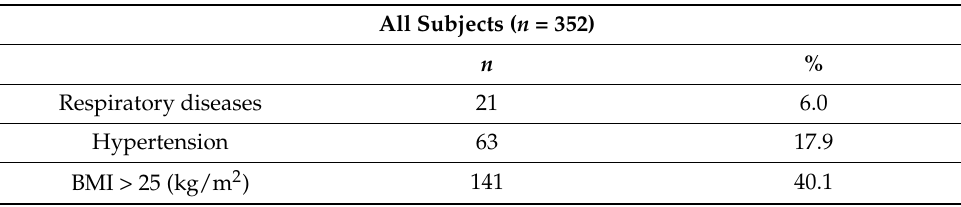
Table 1. The frequency of subjects with respiratory diseases, hypertension, BMI > 25 kg/m 2 and 35-LC in all